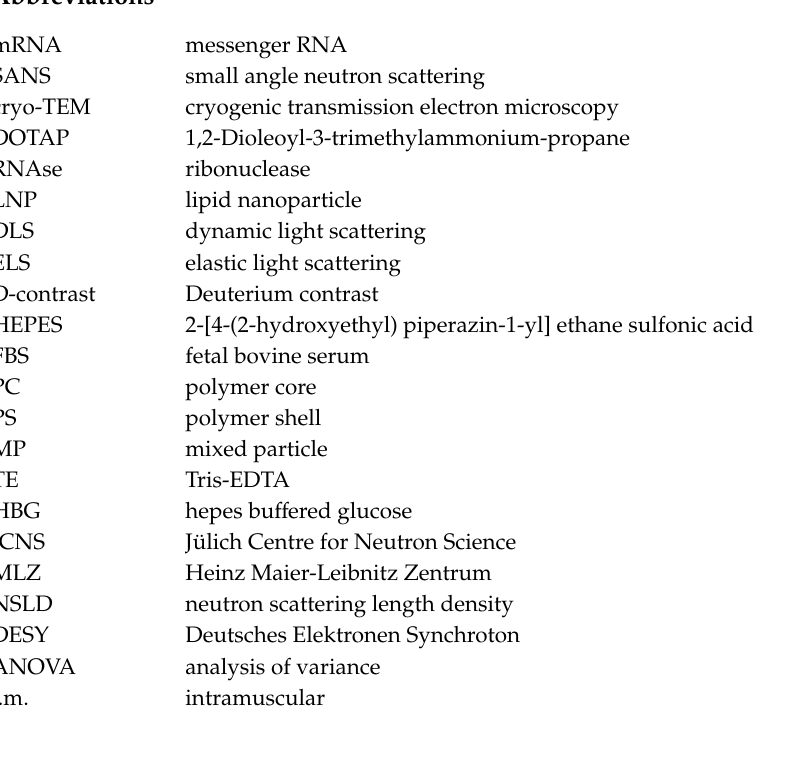
Figure S1: Contrast matching analysis of protamine (PDF), Figure S2: Contrast matching analysis of DOTAP (PDF), Figure S3: Contrast matching analysis of RNA (PDF), Figure S4: Contrast matching analysis of PS MID (PDF), Figure S5: Contrast matching analysis of PC LOW (PDF), Figure S6: Contrast matching analysis of PS HIGH (PDF), Figure S7: Contrast matching analysis of PC LOW peak (PDF); Figure S8: HEK293 cell viability (PDF), Figure S9: C2C12 cell transfection (PDF), Figure S10: C2C12 cell viability (PDF), Table S1: Manufacturing details (PDF), Table S2: Physicochemical analysis details (PDF), Table S3: Theoretical and measured contrast matching points of the single components